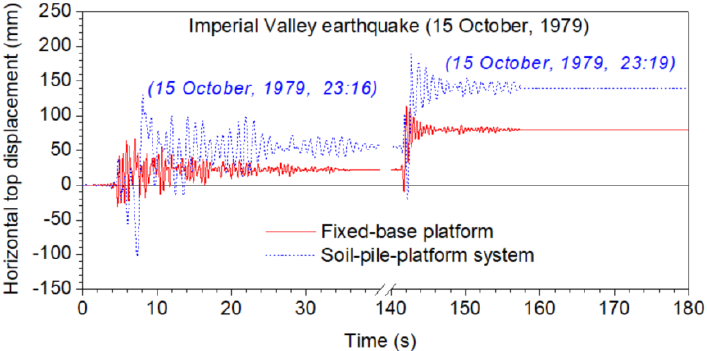
Figure 17. Fixed-base platform vs. soil – pile – platform hybrid system under the Imperial Valley earthquakes (15 October 1979, 23:16~23:19).